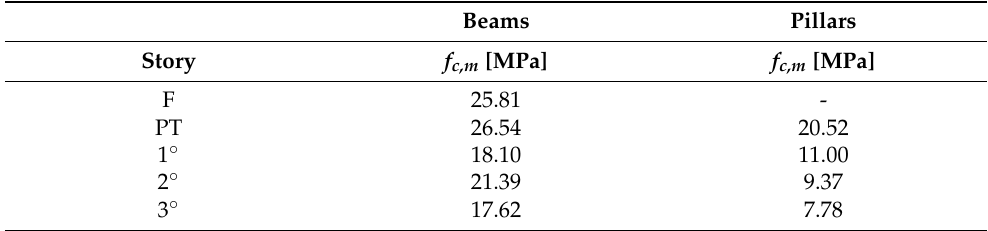
Table 2. Mechanical properties of concrete, based on in-field and laboratory experiments (average values). Beams